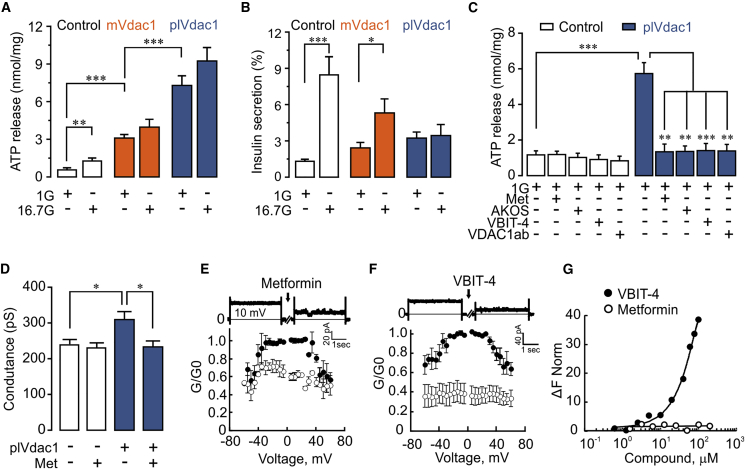
VDAC1 Cell Surface Expression Alters INS-1 Cell ATP Handling, Insulin Secretion, and Membrane Conductance(A) ATP release after 1 hr incubation at 1 or 16.7 mM glucose from INS-1 cells transfected with either mitochondrial Vdac1 (mtVdac1) or plasma membrane-targeted Vdac1 (plVdac1) and control (empty plasmid). Mean ± SEM (n = 4).(B) GSIS measured in the same experiments as in (A).(C) Effect of VDAC1 antibody (VDAC1-ab, 10 nM), metformin, or the VDAC1 inhibitors AKOS022075291 and VBIT-4 (20 μM each) on ATP release after 1 hr exposure at 1 mM glucose of INS-1 cells transfected with control plasmid or plVdac1. Mean ± SEM from at least three independent experiments.(D) Membrane conductance (whole-cell patch clamp) in control and plVdac1-transfected INS-1 cells in the presence or absence of metformin (20 μM) within 1 hr. Mean ± SEM of 15 cells in each group are shown.(E) Metformin (30 μM) reduces conductance of VDAC1 reconstituted in planar lipid bilayers. Average steady-state conductance measured at the indicated voltage, before (•) and 10–30 min after metformin addition (○). Mean ± SEM of three independent measurements. A representative trace at 10 mV is shown at the top.(F) Same as in (E) using VBIT-4 (20 μM).(G) Interaction of VBIT-4 (•) or metformin (○) with soluble VDAC1 (162 nM), using microscale thermophoresis. Results are presented as percent of the bound fraction calculated as given in method.